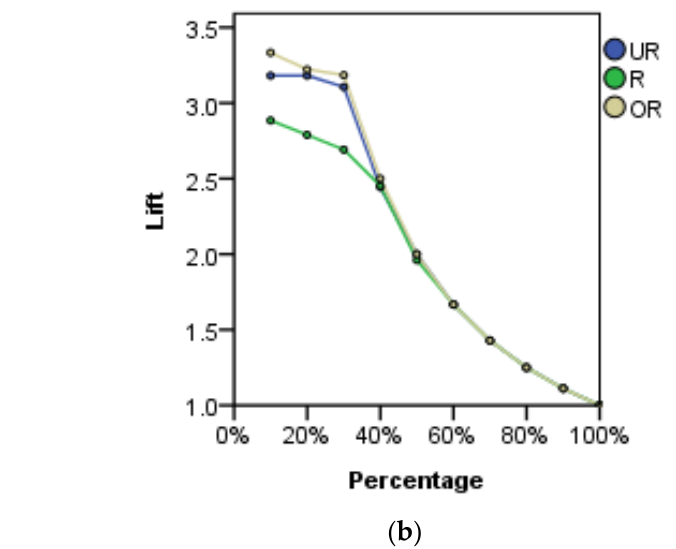
Figure 11. ANN performance measurement ( a ) cumulative gains chart ( b ) lift chart. Table 12. Accuracy comparison of classification methods in the training stage and test stage. Overall Percent (%) Correct Classification Based on Different